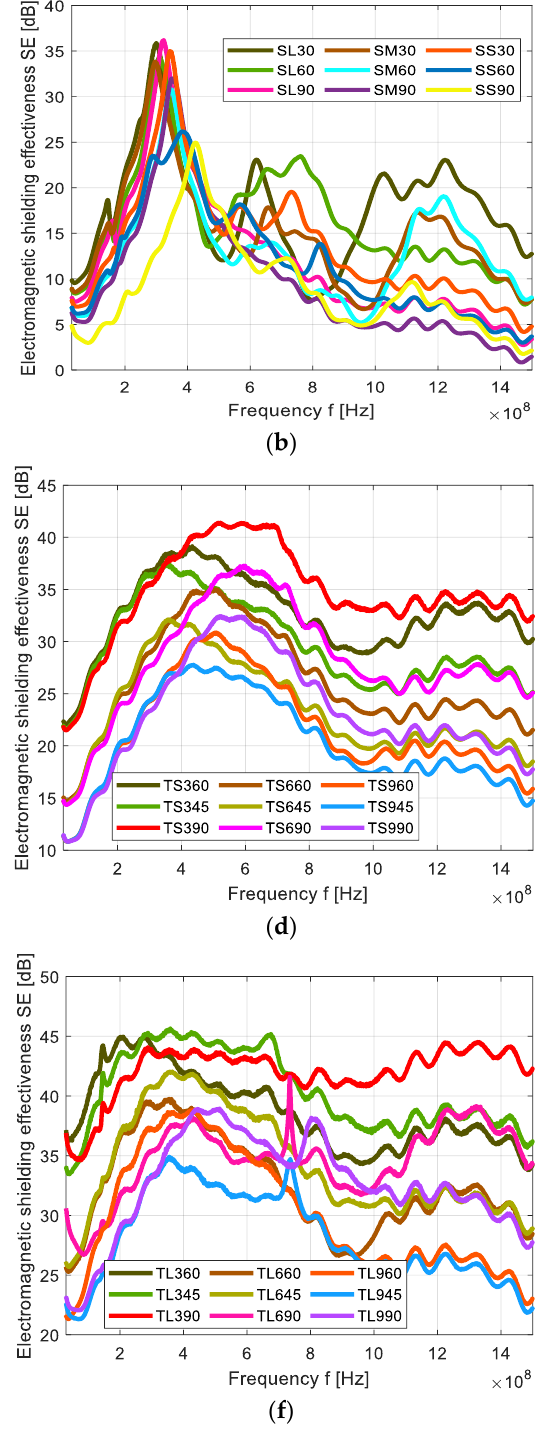
Figure 3. Electromagnetic shielding effectiveness (EM SE) versus frequency of the Cu/Ni NW sample ( a ) single layer (SLF) & two-layer (TLF), ( b ) single layer strips, ( c ) two layers strips laid at 0° angle, ( d ) two layers of 3 mm thick strips laid at 45°, 60° and 90° angles, ( e ) two layers of 6 mm thick strips laid at 45°, 60° and 90° angles, and ( f ) two layers of 9 mm thick strips laid at 45°, 60° and 90° angles.